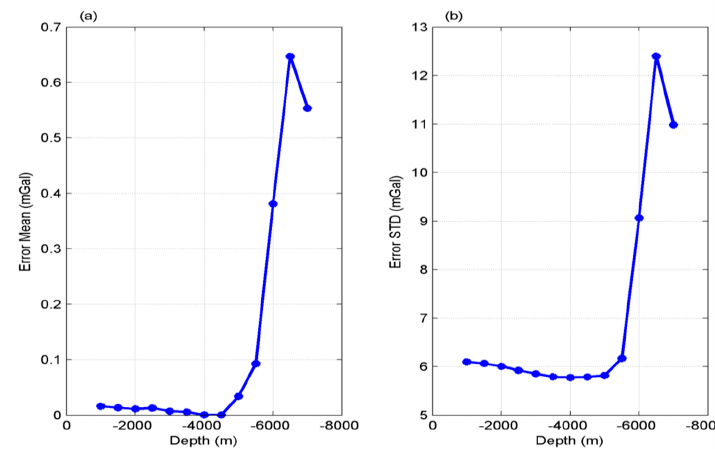
Figure 9. Ratio of the gravity disturbance error compared to EGM2008.